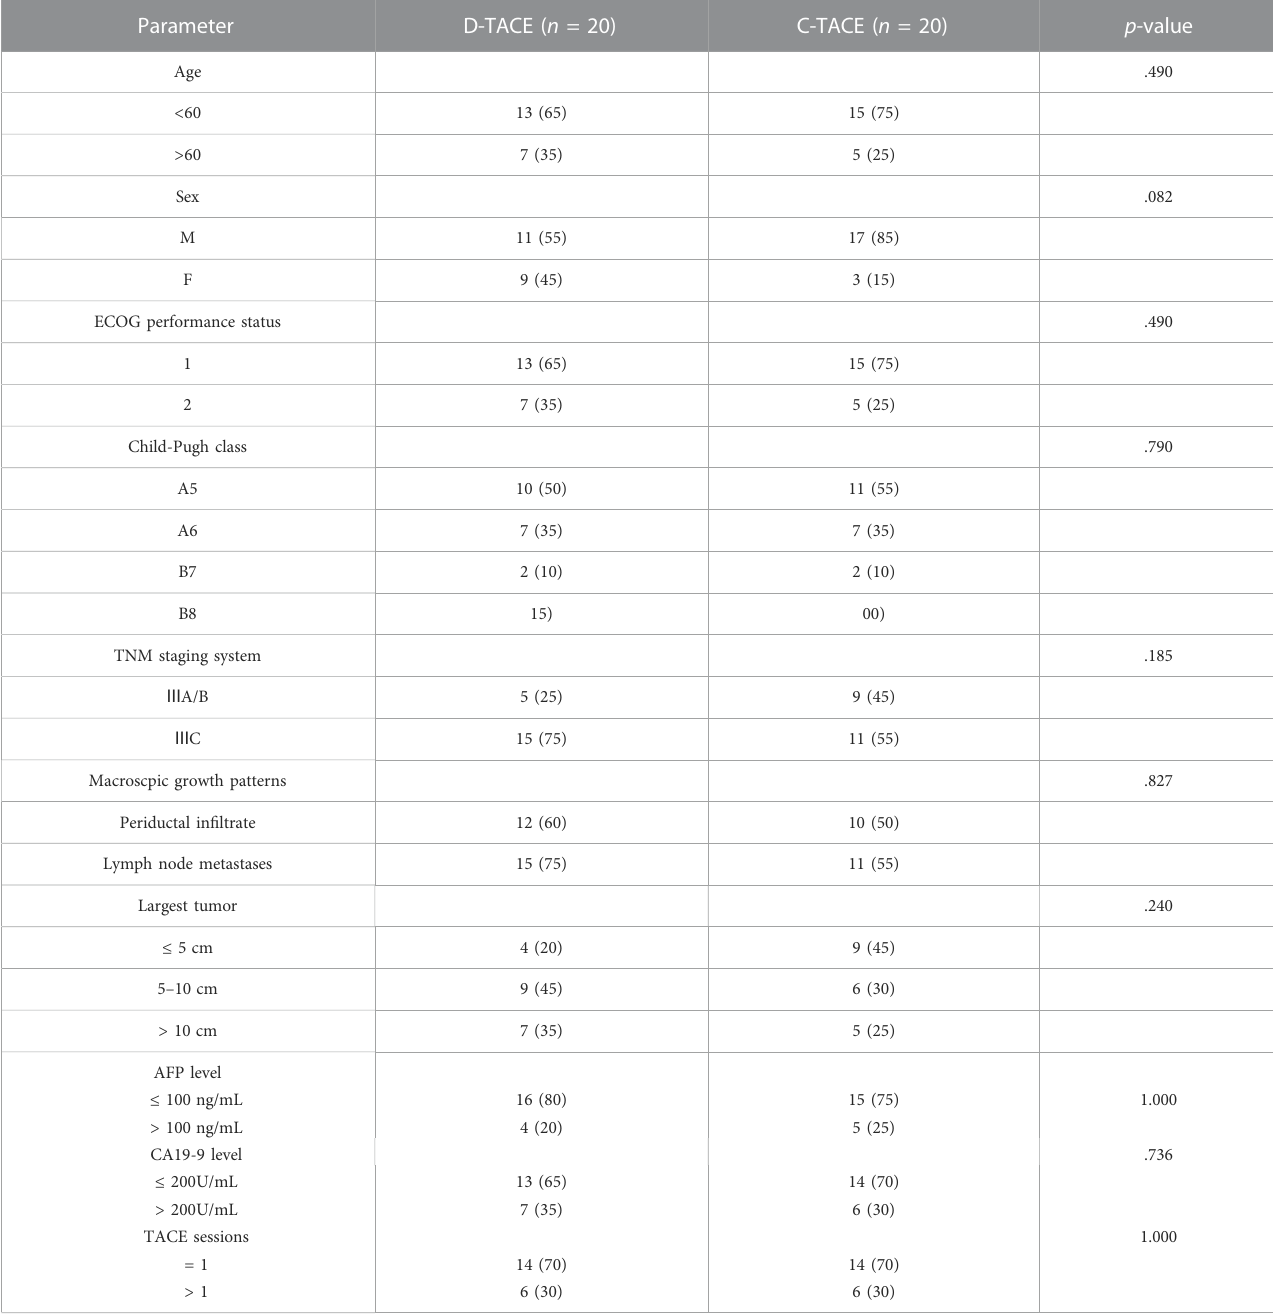
TABLE 1 Baseline characteristics of the study